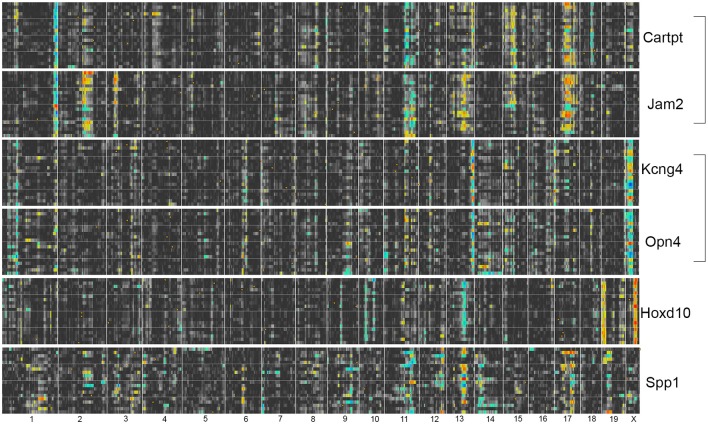
Heat maps for RGC subtype-specific marker genes. Cartpt/Jam2 share the trans-band on distal Chromosome 1 with the Thy1-network, whereas Kcng4/Opn4 share the Thy1-network trans-band from Chromosome 13. There is no obvious overlap of trans-bands with either network for Hoxd10. For Spp1, no obvious trans-bands can be appreciated, suggesting that this gene is not part of a transcriptional network in its normal state.